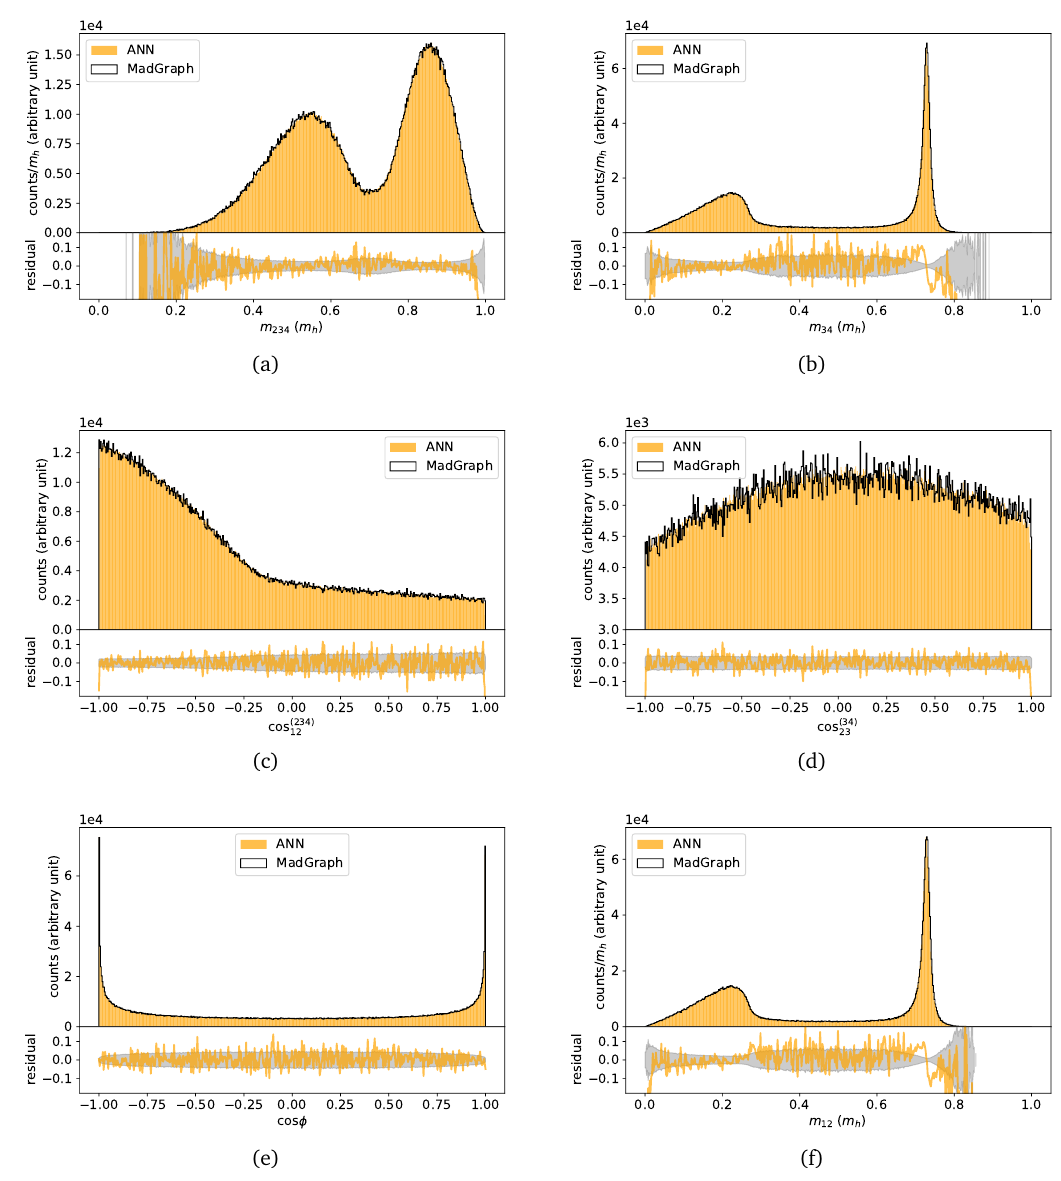
Figure 5: Kinematic distributions of h → 4 (cid:96) decays in the five coordinates chosen to parametrize the final-state phase space (a-e) and in the invariant mass m is not aligned with any of the chosen coordinates but contains a resonance (f). The coordinates have been rescaled from the unit hypercube back to their original val- ues. The output of the ANN-based simulation (after unweighting) is represented by orange solid histogram. For comparison, distributions generated by MadGraph are shown by black lines. Residuals are shown beneath each plot. The grey bands are statistical uncertainties from random sampling of the phase space and event un-